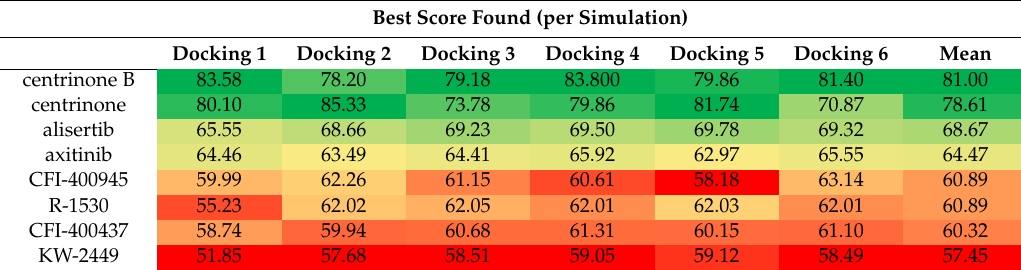
Table 1. In silico molecular docking scores of the protein kinase inhibitors to the binding cavity of PLK4 (GOLD 5.2, CCDC). Six simulations per kinase inhibitor were performed. Green—highest score; Red—lowest score. Best Score Found (per